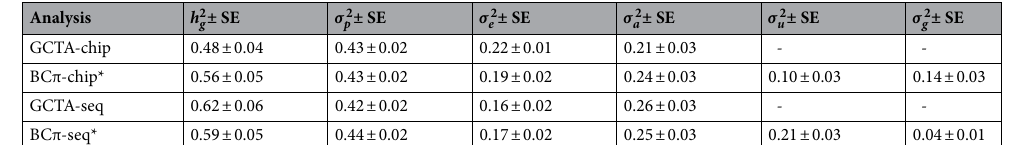
Table 3. Estimates of genetic and genomic parameters for spontaneous maleness under the different statistical models. h 2 G : genomic heritability, calculated as σ 2 a /(σ 2 a + σ 2 e ) . σ 2 a : total genetic variance ( = σ 2 u + σ 2 g ), σ 2 u : polygenic variance, σ 2 g : genetic variance explained by SNPs, σ 2 e : residual variance, σ 2 p : phenotypic variance + σ 2 ( = σ 2 e ). *Value of one MCMC chain among the two used for GWAS, the chain with the closest final π to a the 1% or 0.02% was chosen.